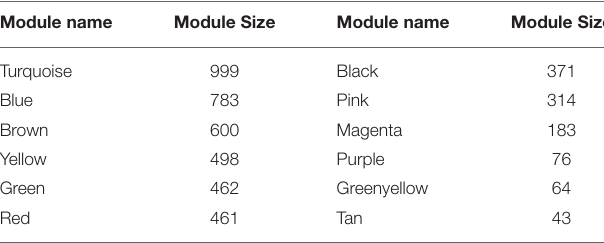
genes with ANGPTL8 across all the samples and conditions. TABLE 1 | Modules resulted from the hierarchical clustering: Module names are assigned colors and module size corresponds to the number of genes clustered in each